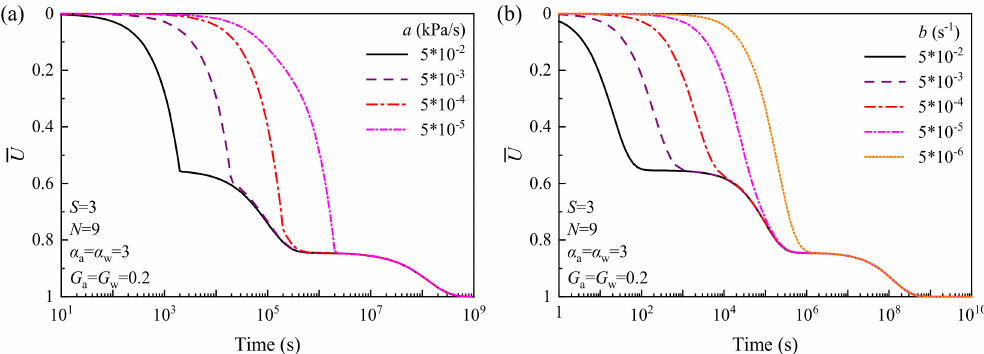
Figure 5. Consolidation patterns of the PVD foundation under ( a ) ramp and ( b ) exponential loadings against various loading parameters of a and b